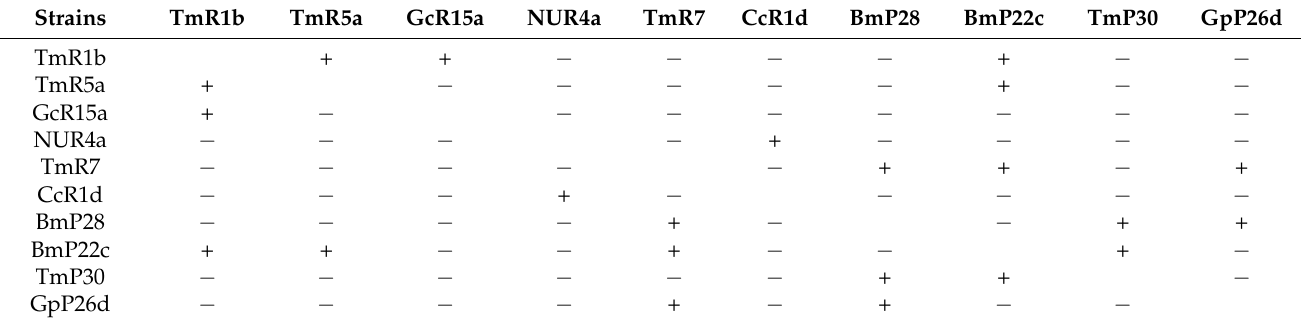
Table 5. Compatibility between selected bacterial